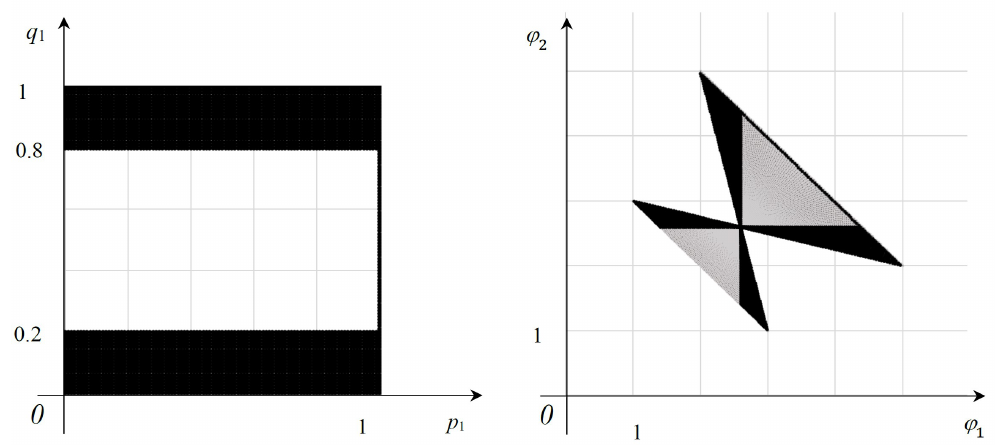
Figure 5. Game (17). The set of equilibrium outcomes (on the left) and the set of equilibrium values (on the